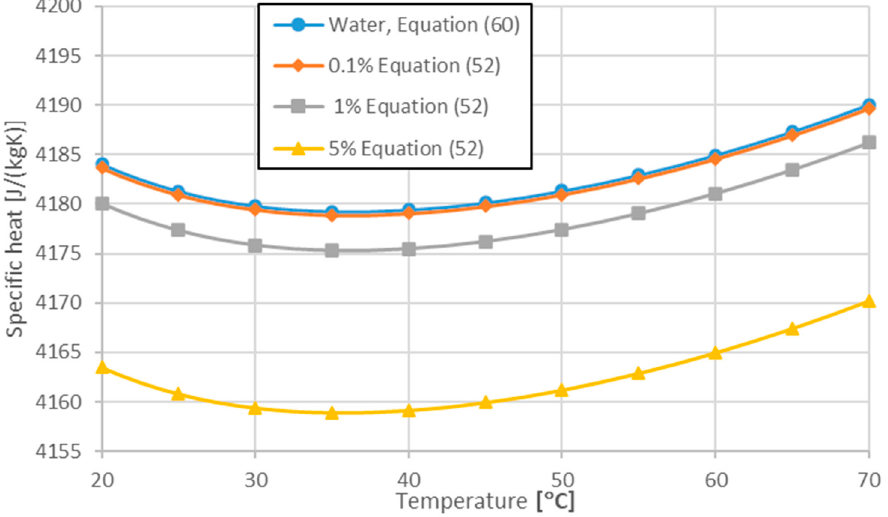
Figure 10. Specific heat of water-Al 2 O 3 nanofluids.